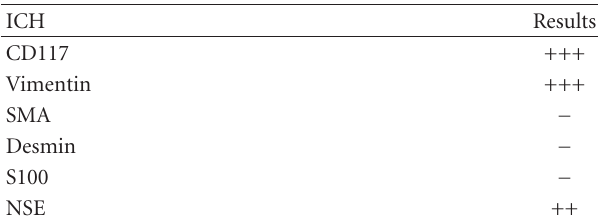
Table 1: Slight staining (+), moderate staining (++), strong stain- ing (+++), no reaction ( − ).